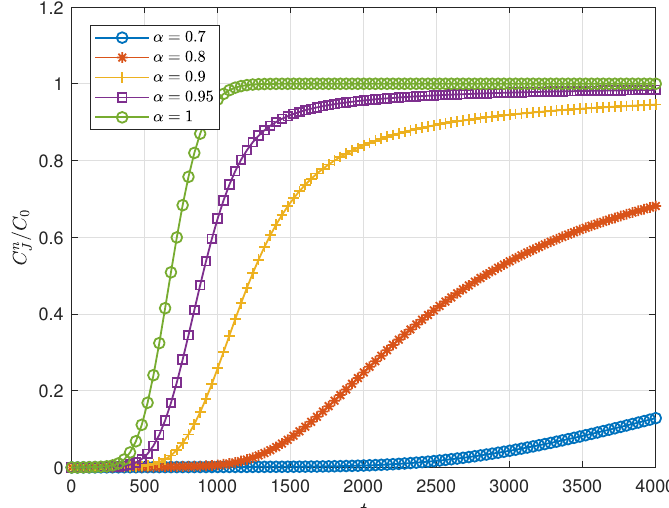
Figure 5. Breakthrough curves obtained by plotting the outflow/inflow concentration ratio ( C / C 0 ) for different values of fractional order α at the exit x J